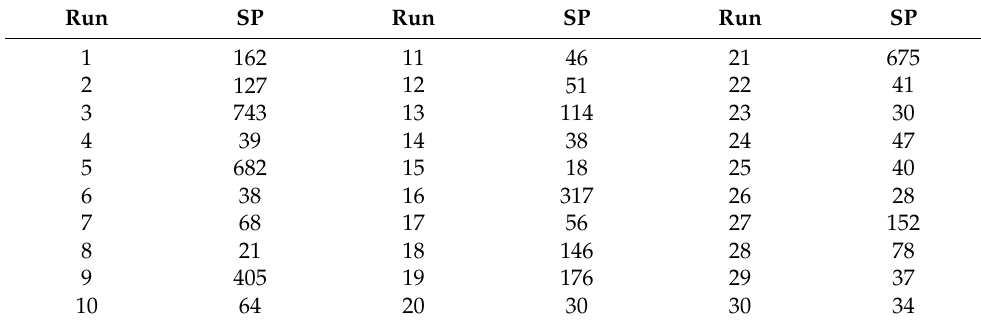
Table 3. Stagnation points for the first 30 runs of the EA-based hyper-heuristic